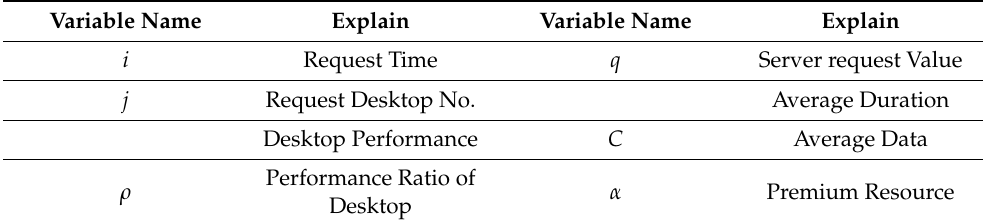
Table 5. Resource allocation design based on BIM